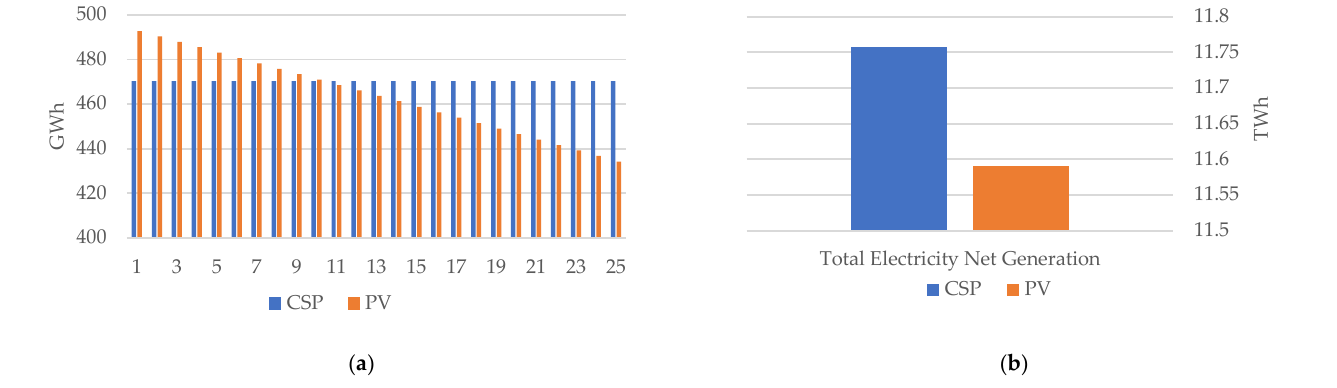
Figure 4. Monthly AC Energy in year 1 for both PV and CSP plants.